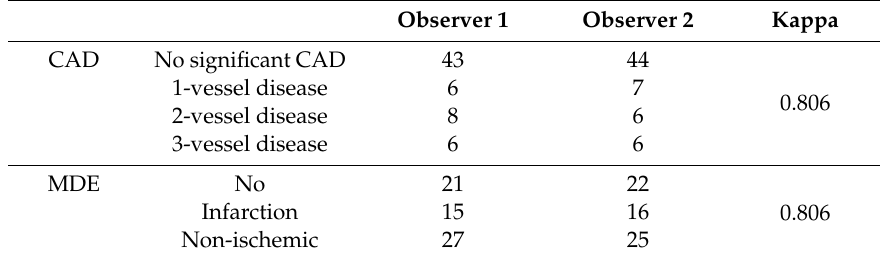
Table 2. Inter-observer agreement for main findings on cardiac